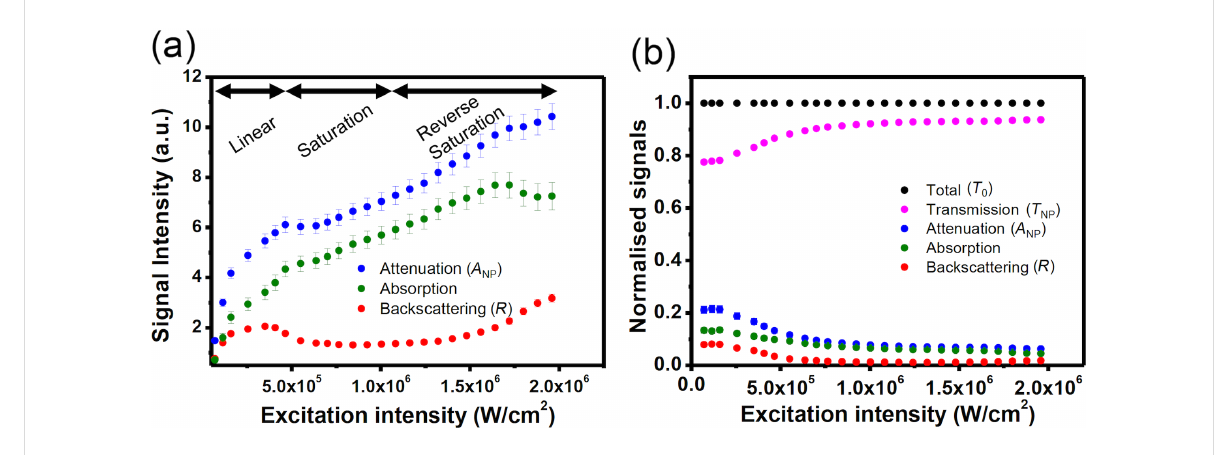
Figure 5: (a) Excitation intensity dependent attenuation (blue dots), absorption (green dots) and backscattering (red dots) signals. (b) Normalized signals (i.e., proportional to the corresponding cross sections) as functions of the excitation laser intensity.